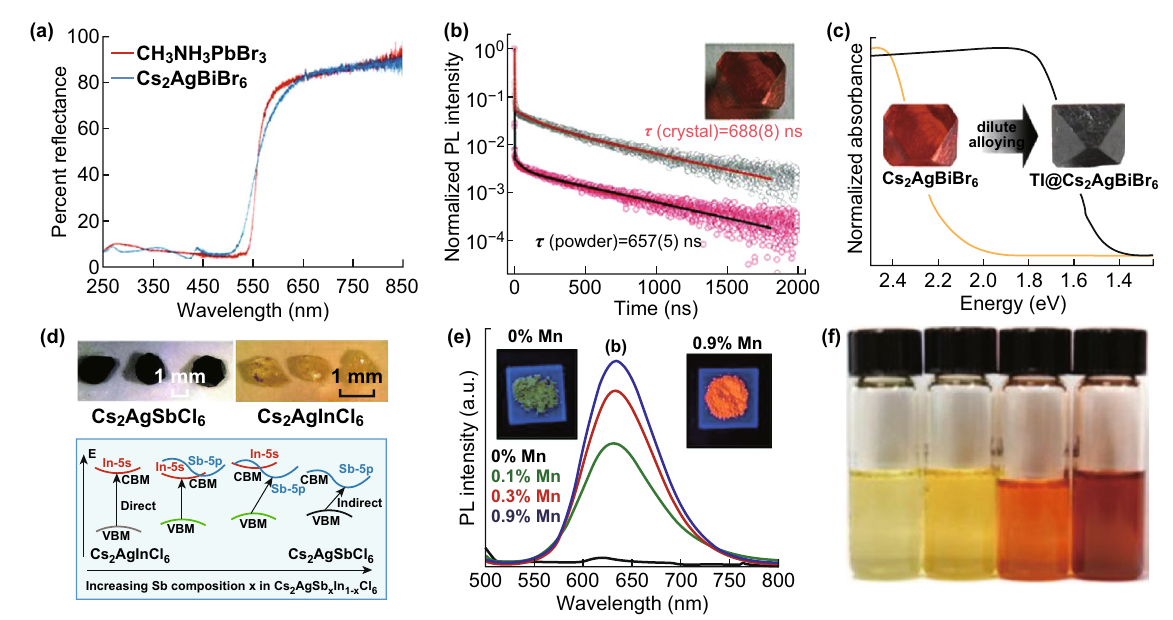
Fig. 2 a Diffuse reflectance spectra of Cs 2 AgBiBr 6 and CH 3 NH 3 PbBr 3 . Reproduced with permission from Ref. [48]. b Time-resolved room- temperature PL and fits for the PL decay time (τ) in powder and single-crystal samples. The inset is the photograph of a Cs 2 SgBiBr 6 single crystal. Reproduced with permission from Ref. [52]. c Apparent bandgaps of Cs 2 AgBiBr 6 and Cs 2 (Ag 1−a Bi 1−b )TlxBr 6 ( x = a + b = 0.075) single crystals extracted by linear fits to α 2 vs. E (direct gap) and α 1/2 vs. E plots (indirect gap). Reproduced with permission from Ref. [57]. d Pho- tographs of Cs 2 AgSbCl 6 and Cs 2 AgInCl 6 single crystals (top), and band diagram. A change in the character of the conduction band minimum (CBM) from s orbital derived to p orbital derived while having the valence band maximum (VBM) primarily Ag-d states results in a transition from direct to indirect bandgap. Reproduced with permission from Ref. [59]. e PL spectra of Mn-doped Cs 2 AgInCl 6 with different Mn contents, after excitation with 340 nm light. Insets show photographs of luminescence from powder samples under UV light. Reproduced with permission from Ref. [62]. f Photograph of dilute toluene solutions of Cs 2 AgBiBr 6 , Cs 2 AgBiBr 5.2 I 0.8 , Cs 2 AgBiBr 1.6 I 4.4 and Cs 2 AgBiI 6 nanocrystals. Repro- duced with permission from Ref.